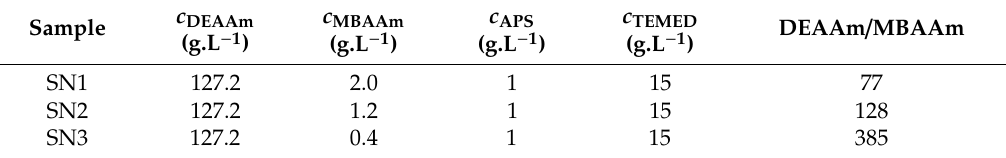
Table 1. Chemical composition of reaction mixtures used in the preparation of single network (SN) hydrogels: mass concentrations of DEAAm ( c DEAAm ), MBAAm ( c MBAAm ), ammonium persulfate (APS) ( c APS ), and TEMED ( c TEMED ), and molar ratio of DEAAm and MBAAm in polymerization solution. c DEAAm Sample (g.L − 1